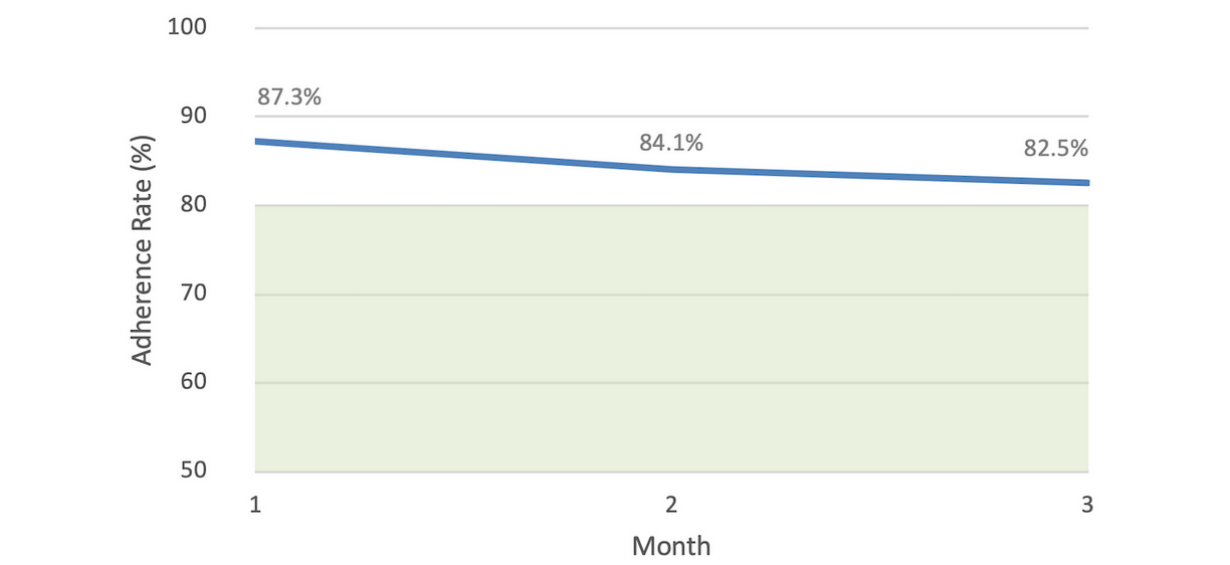
Figure 2. Mean implementation adherence rates of 243 users of the Perx app over 3 months. The shaded area below 80% indicates less than optimal adherence based on the literature.